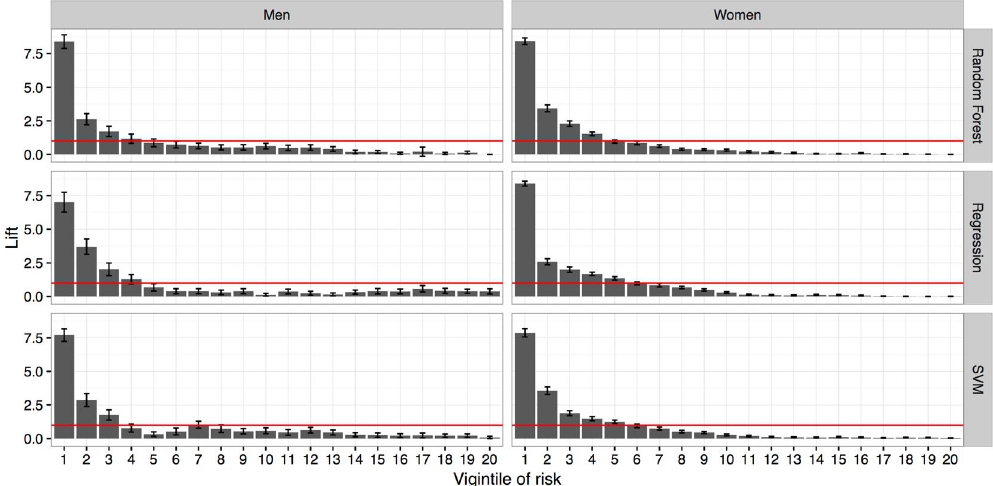
Figure 2. Vigintile-wise Lift chart of classification models for men and women. The horizontal lines in the subfigures indicate the average positive predictive value. SVM: Support vector machine.